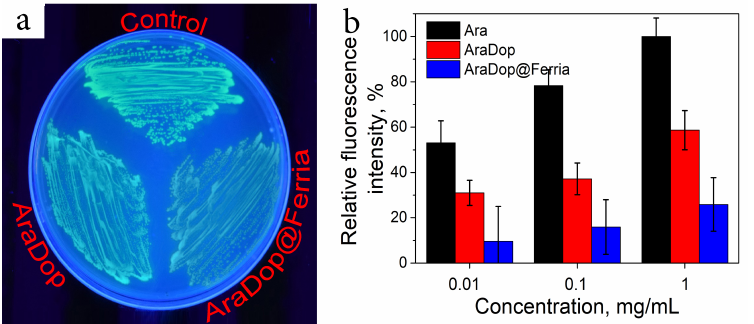
Figure 6. Bioactivity of AraDop@Ferria. ( a ) Visual appearance of fluorescent E. coli Nova Blue pBad; ( b ) Fluorescent signal in response to various arabinose species.